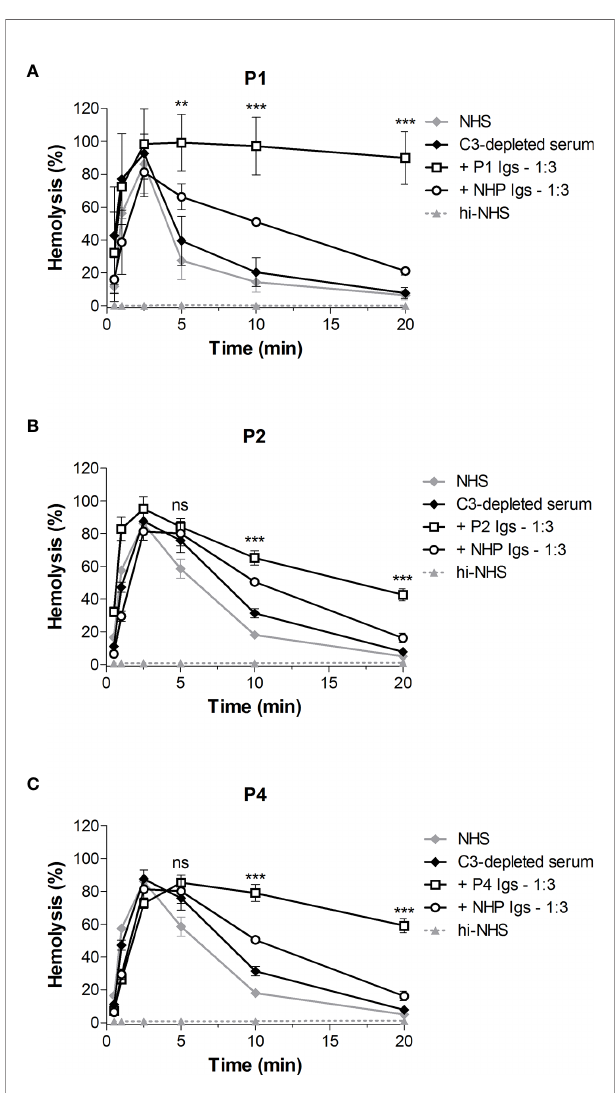
FIGURE 5 | Classical pathway C3 convertase (C4b2a) stabilization by patient immunoglobulins. Sensitized sheep erythrocytes were incubated with C3- depleted serum supplemented with immunoglobulins (Igs) from P1 (A) , P2 (B) , or P4 (C) in a 1:3 volume ratio. Igs from normal human plasma (NHP) were used as a control. Hemolysis levels are presented as percentage of full lysis of erythrocytes in water. Data are presented as the mean and the standard deviation of three independent experiments. Signi fi cance values according to two-way analysis of variance with Bonferroni post-test with C3- depleted serum + NHP Igs as the control condition are given for t5, t10, and t20: ***P < 0.001; **P < 0.01; ns, not signi fi cant. NHS, normal human serum; hi-NHS, heat-inactivated